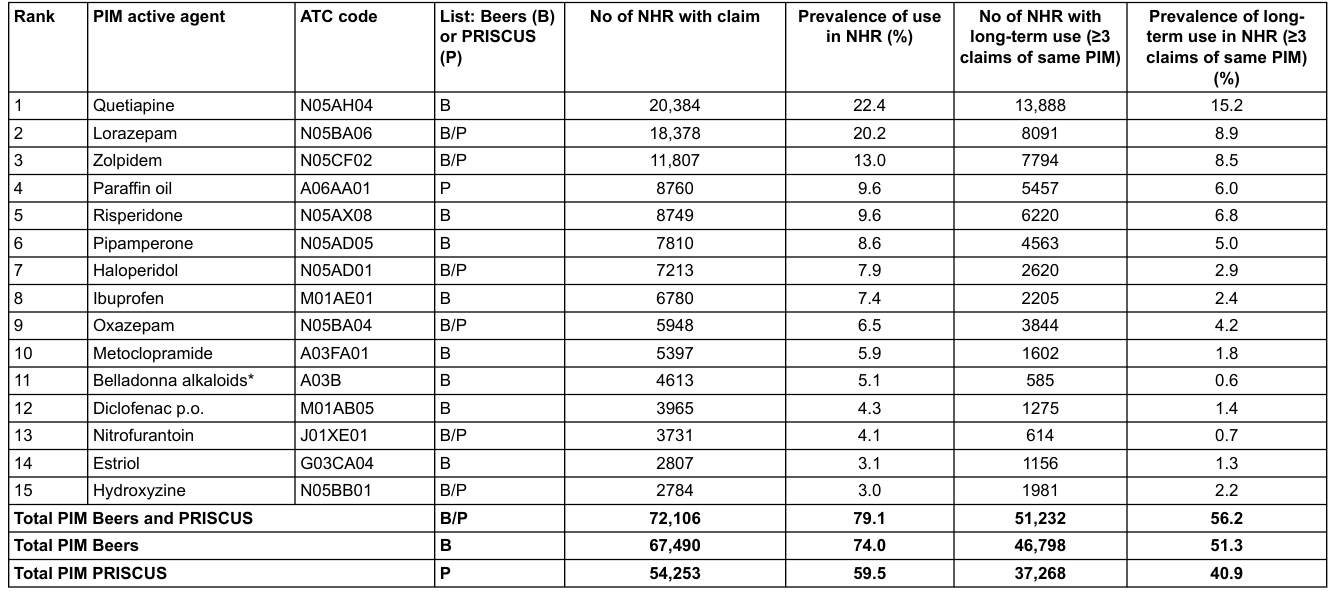
Table 4: The 15 most frequent PIM and the prevalence of their use in NHR according to the 2015 Beers criteria and PRISCUS list [8, 14], ranked by total number of recipients, year 2016. Rank PIM active agent ATC code